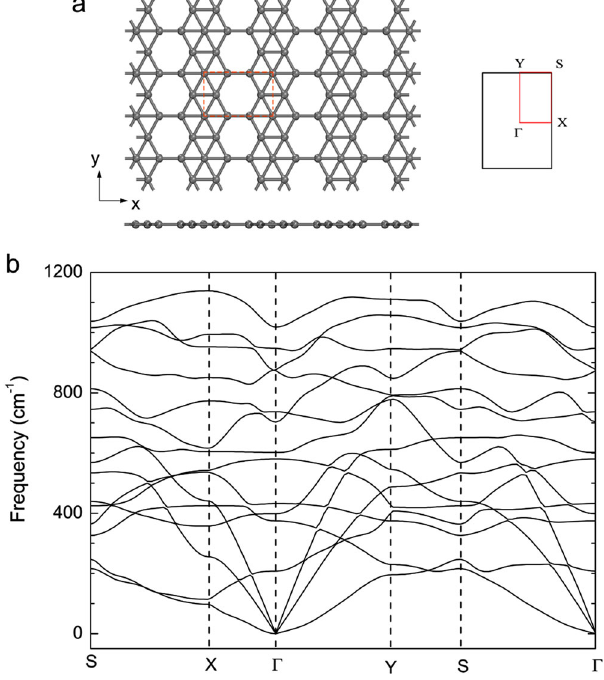
Fig. 5 Structure and phonon dispersion of β 12 borophene. a Atomic model ( top and side views) of the β 12 borophene sheet. The unit cell is highlighted with dashed lines . The right panel shows the Brillouin zone. b Phonon dispersion of β 12 borophene based on fi rst- principles